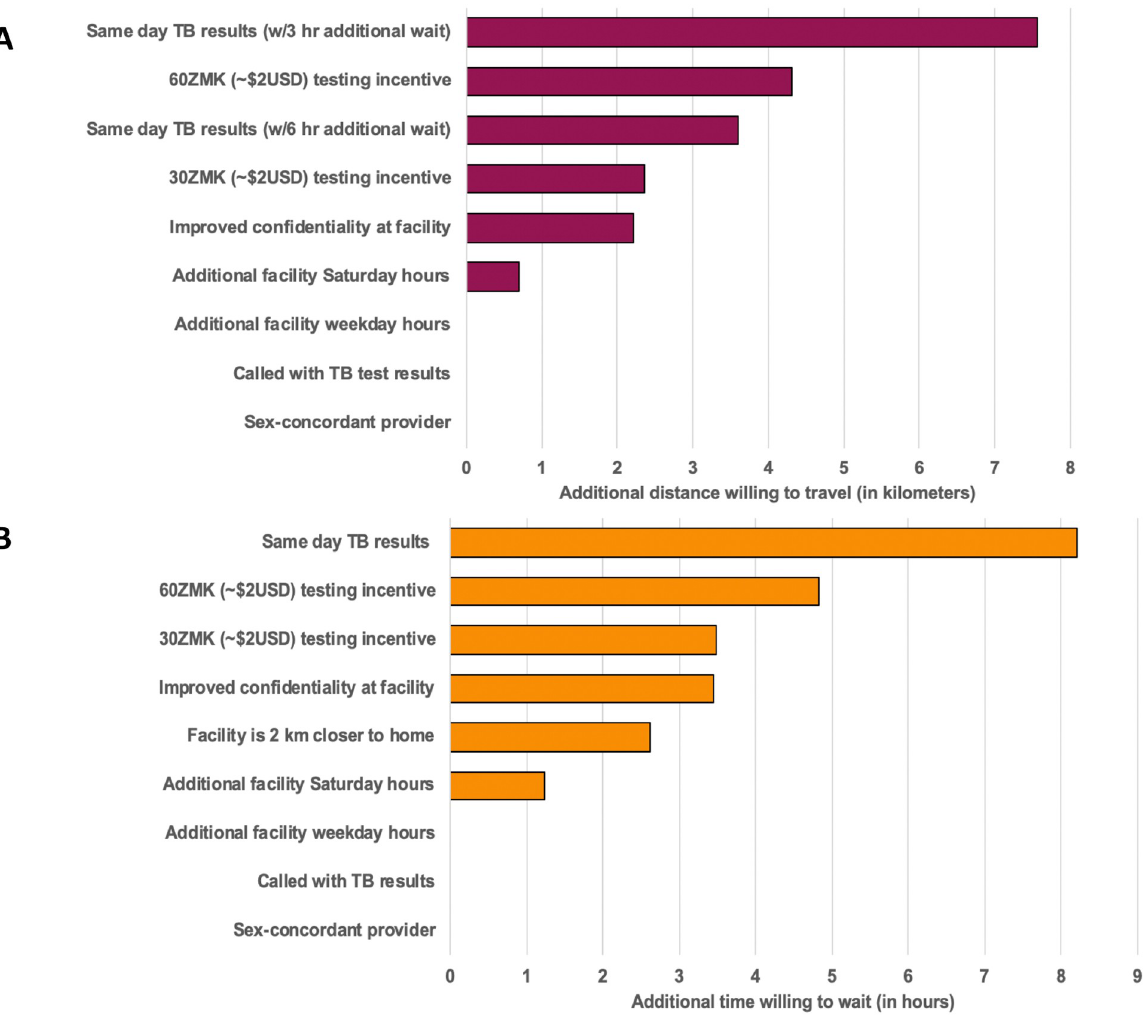
Fig 5. Tradeoffs patients were willing to make in order to access a facility offering different enhanced services: (a) additional willingness to travel (in kilometers), (b) additional willingness to wait (in hours). Willingness to travel and wait values were calculated using the following assumptions for a “usual” tuberculosis health facility in Lusaka, Zambia: it is 2 kilometers from an individual’s home, requires two hours spent at the clinic waiting and undergoing evaluation (based on the median amount of time cited by survey participants on their date of TB diagnosis), it is only be open during typical business hours Monday through Friday, an individual may be known or recognized there, is does not offer sex- concordant health care providers, it does not offer financial incentives for undergoing TB testing, and it requires individuals to return on a different day to collect their TB test results. Because it is not feasible to implement same-day TB testing without an additional wait time for patients, in the willingness’s to travel analyses, we assumed that patients would need to wait an additional 3 hours (minimum estimated time required for sample collection and transport, Xpert testing, and result notification), or 6 hours (total wait time of 5 or 8 hours, respectively), in order to access same-day TB